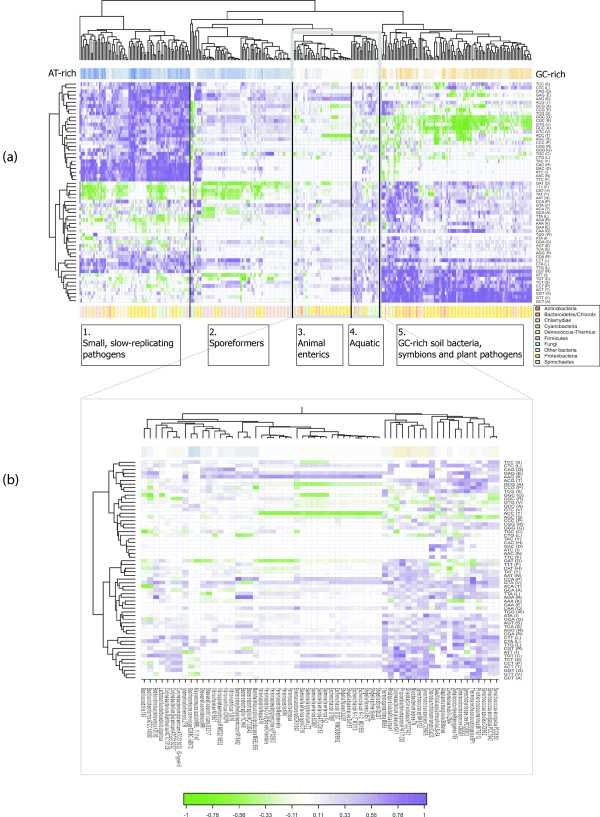
Two-dimensional cluster analysis of differential codon preferences for tCAI and dCAI. The differences in relative adaptiveness of each codon (wij for tCAI minus wij for dCAI) for each Genbank entry were clustered into two dimensions, one clustering codons and the other clustering Genbank entries. The clustering was performed as a hierarchical cluster analysis using Euclidian distances and complete linkage. Codons preferred relatively more by dCAI are red, whereas codons preferred relatively more by tCAI are green. Equal preference is indicated by white. (a) Entire dendrogram. The five major regions are indicated and microbial names are replaced by a color bar reflecting each microbe's phylum. (b) Zoom of the third and fourth regions. Weights not considered: start codon 'ATG' and stop codons 'TGA', 'TAG' and 'TAA'. dCAI, dominant codon adaptation index; tCAI, translational codon adaptation index.